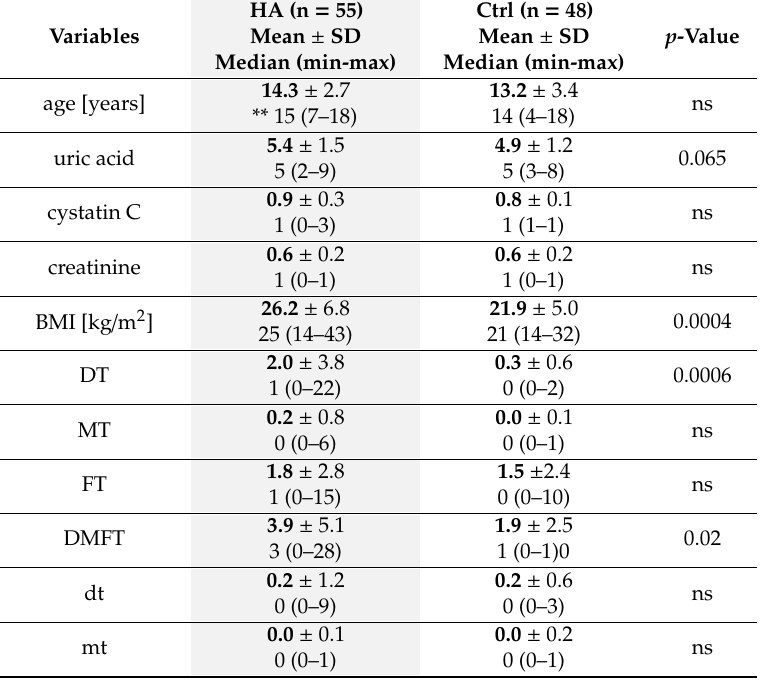
Table 1. Anthropometric, biochemical, and oral data, for HA and Ctrl